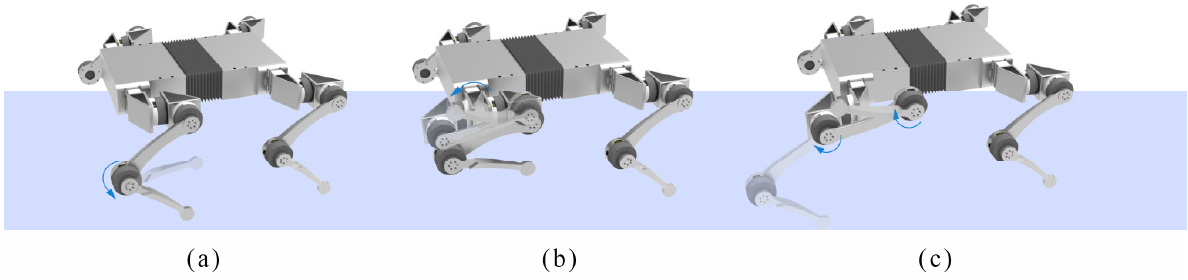
Figure 8. Motion diagram of left foreleg: mammal form to reptile form: ( a ) Actuator 4 drives the calf to move closer to the thigh; ( b ) Actuator 2 drives the whole leg; ( c ) Actuators 3 and 4 drives the thigh and calf to move until the calf touches the ground.